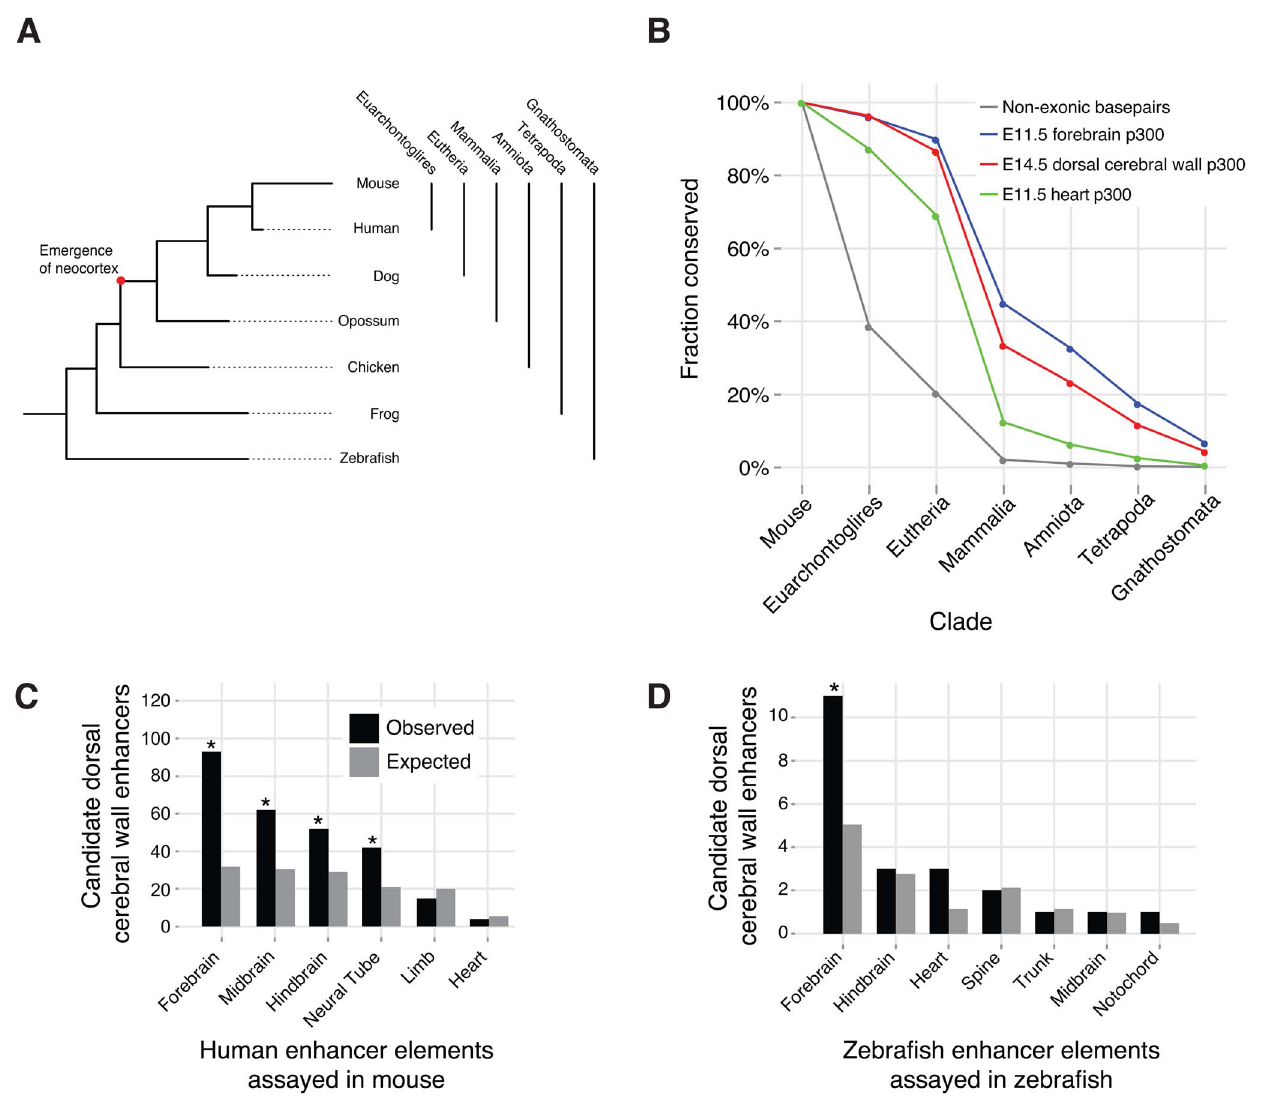
Figure 5. Conservation and additional functions of candidate dorsal cerebral wall enhancers. A) The phylogeny of vertebrate evolution. B) Evolutionary conservation of E14.5 dorsal cerebral wall enhancers compared to other p300 ChIP-seq sets and all genomic non-exonic bases. Each element belongs to a single x-axis category, which is the furthest evolutionary node to which it is conserved (see Methods). C) Overlap of E14.5 p300 peaks with regions for which the human ortholog functions in an E11.5 mouse transgenic enhancer assay (* denotes enrichment p-value , 10 2 5 ). D) Overlap of E14.5 p300 peaks with regions for which the zebrafish ortholog functions in a zebrafish transgenic enhancer assay (* denotes enrichment p-value ,